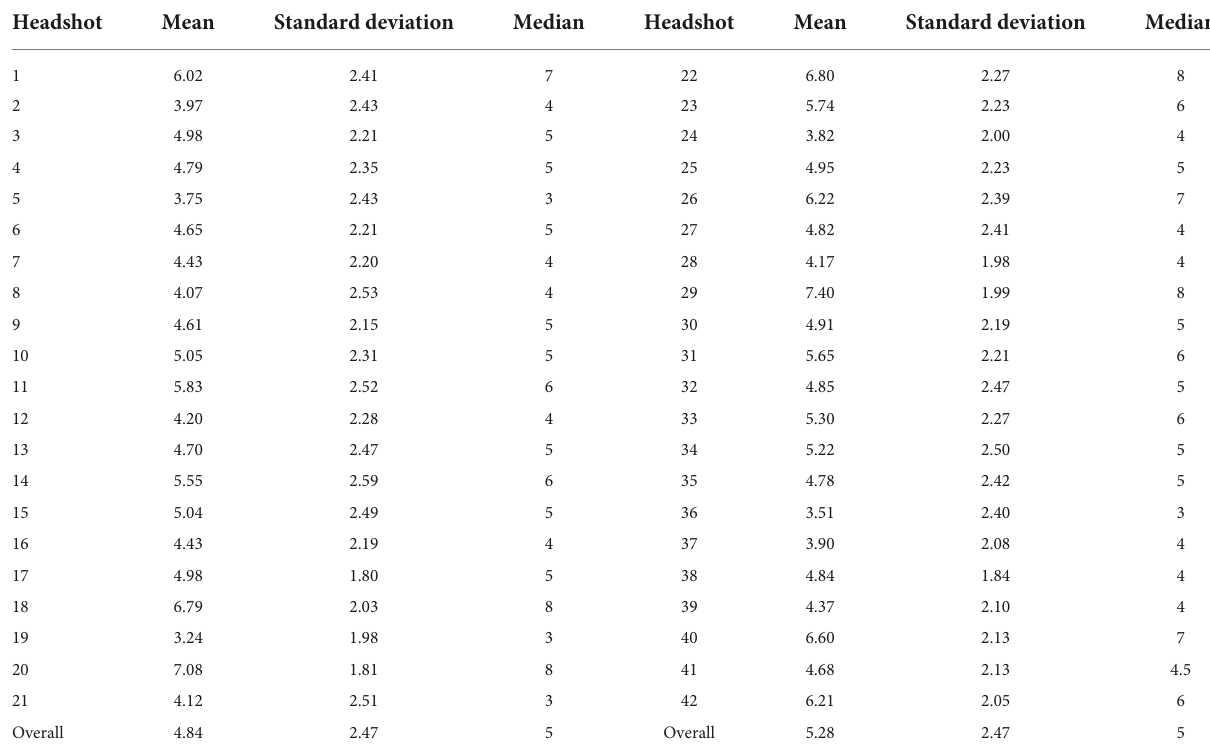
TABLE 1 Summary statistics of attractiveness